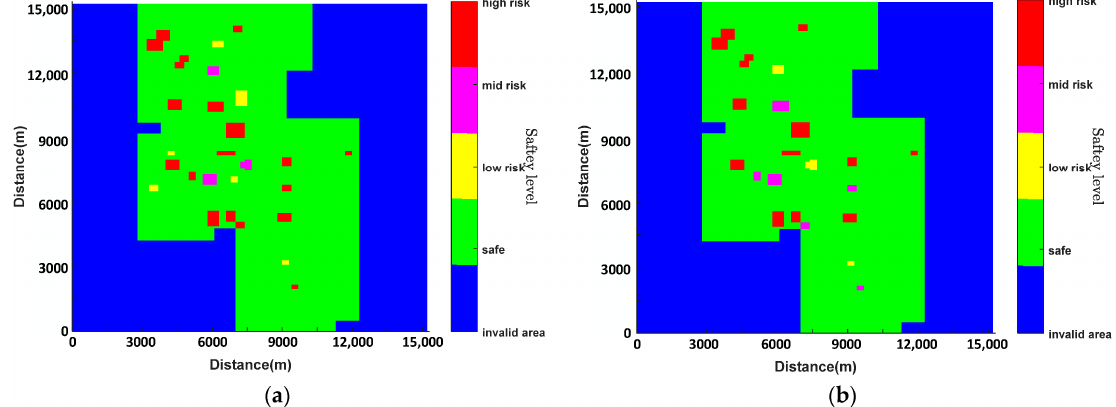
Figure 9. Obstacle layers. ( a ) Layer for Talon; ( b ) Layer for DJI Inspire